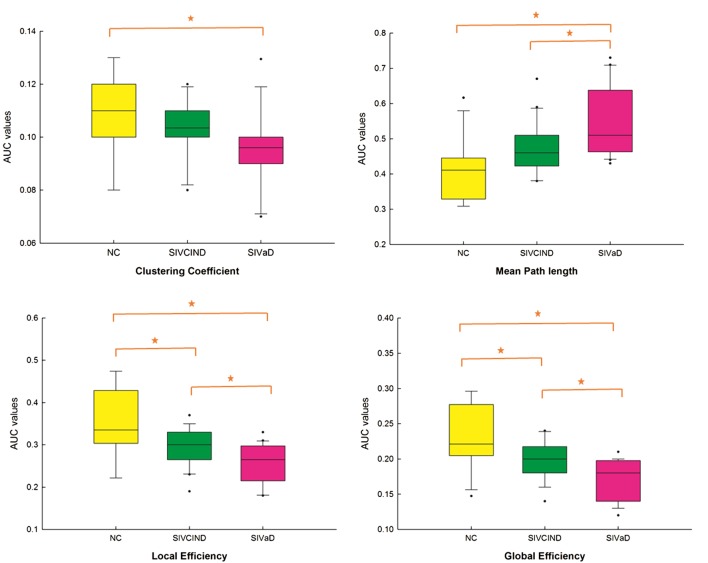
Boxplot of mean area under the curve (AUC) network metric values for each group. Between-group differences were assessed by one-way ANOVA and post hoc Games-Howell test (p < 0.05). The AUC value corresponds to the AUC in plotting the network metric values as a function of the sparsity applied to the connectivity matrix.